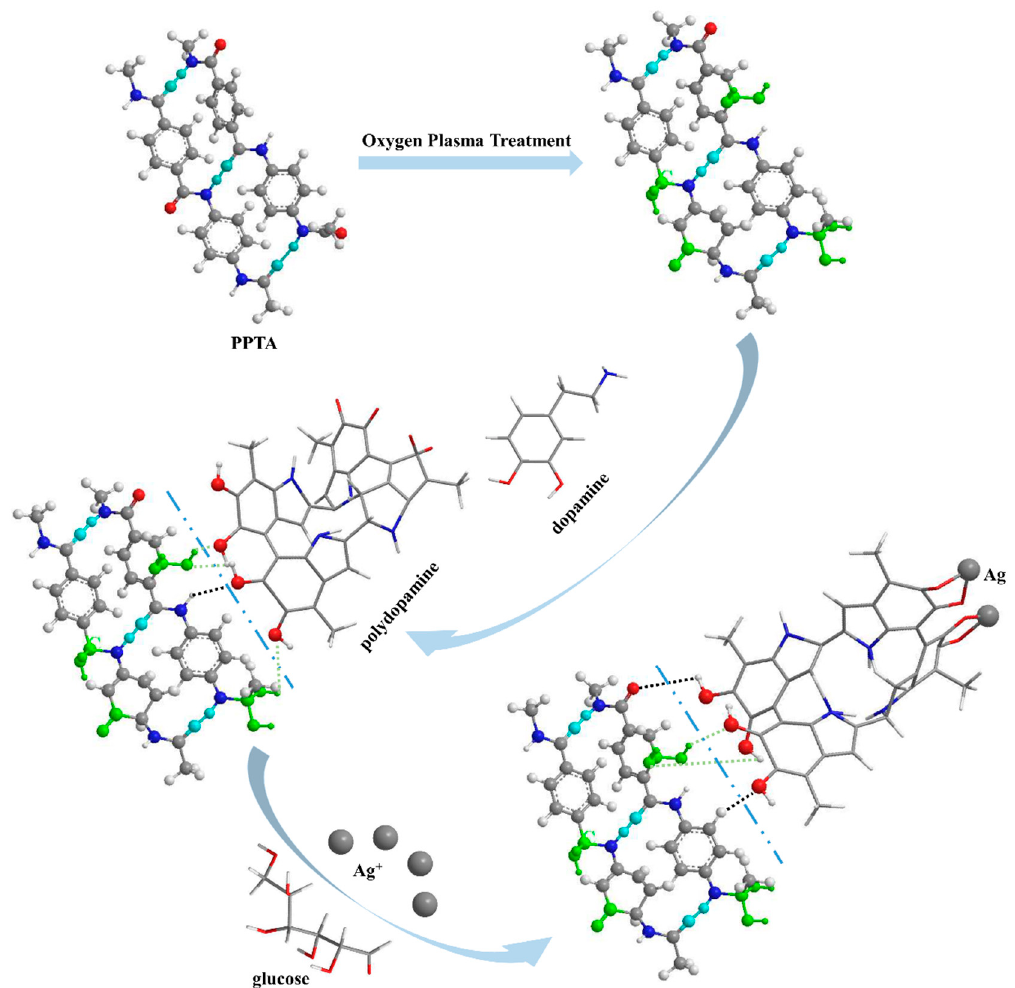
Figure 2. Schematic illustration of the process to obtain silver-plated Poly ( p -phenylene terephthamide) (PPTA) fibers.